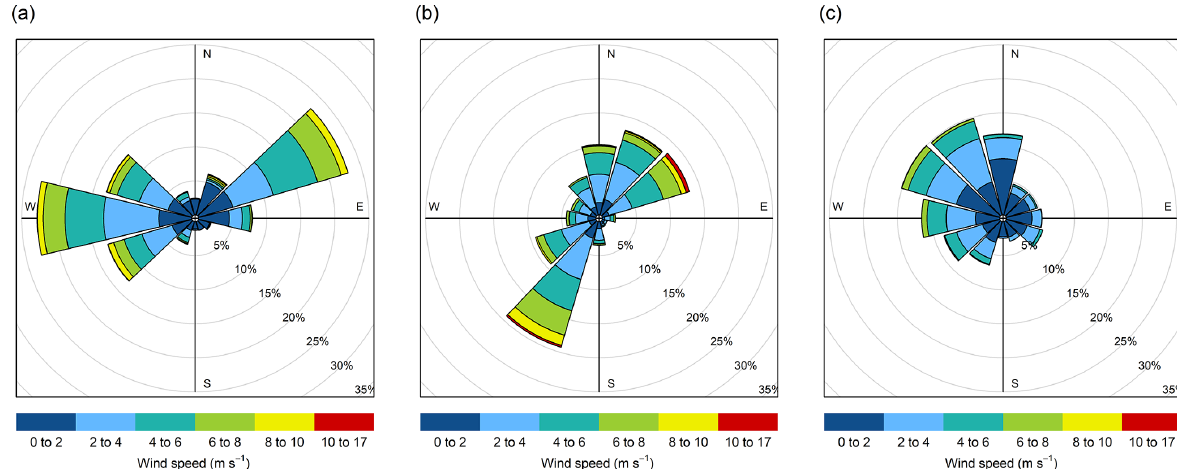
Figure 2. Winter period wind rose plots of the sites. (a) Sainte-Marthe, (b) Saint-Maurice, and (c) Montmorency.